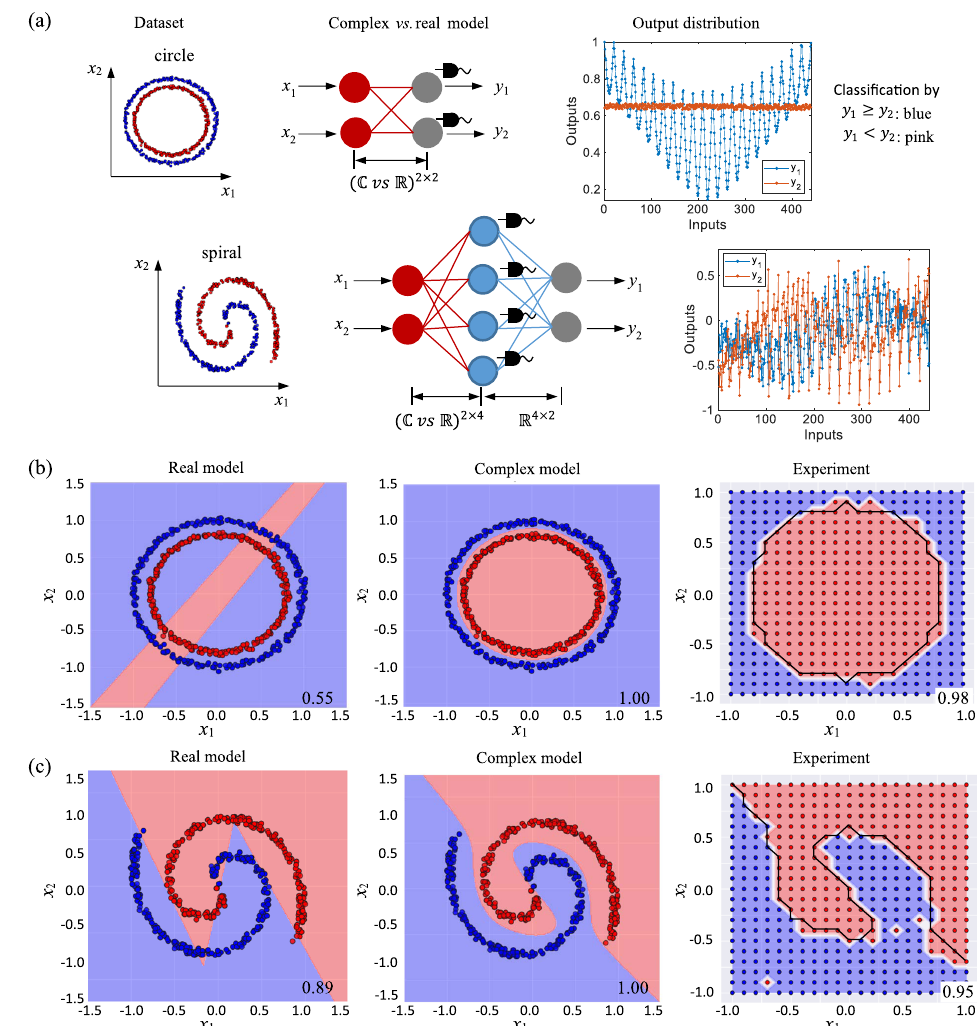
Fig. 5 Nonlinear decision boundaries by complex-valued networks. a Displayed from left to right are the dataset visualization, model construction and measured chip outputs. Two nonlinear datasets, the Circle and the Spiral, are investigated. Both datasets have two real-valued inputs and two classes. For classi fi cation of the Circle, a single layer (designed as complex vs. real for comparison) with two neurons is used. Intensity detection (represented by the PDs) is performed to the chip outputs. For the Spiral, a two-layer network is adopted. The fi rst layer has four neurons, which are designed as complex/real- valued for comparison. Intensity detection is performed to the fi rst layer. The second layer is a real-valued linear mapping between the hidden and output nodes. In chip implementation, we scan both inputs x 1 and x 2 from − 1 to 1 by a step of 0.1. The output distribution ( y 1 , y 2 ) measured on the chip are shown, from which the classi fi cation results can be interpreted by the manner of Argmax : if y 1 ≥ y 2 , the instance belongs to the class blue, otherwise it belongs to the class pink. b The sub fi gures from left to right are the decision boundaries of the Circle, achieved, respectively, by the simulated real and complex model, as well as the chip implementation of complex model. In experiment results, the black wires are our expected decision boundaries, while the white wires are the experimental ones. The classi fi cation accuracy is displayed at the lower right corner of each sub fi gure. The same results of the Spiral are shown in c